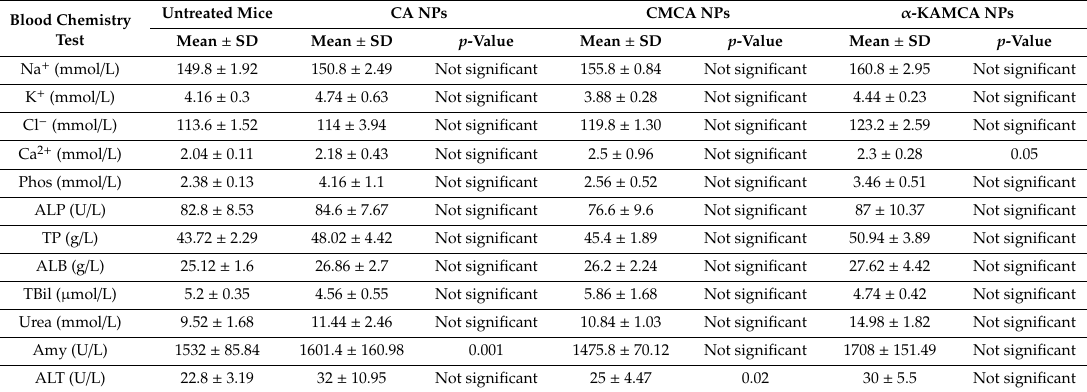
Table 5. Sub-chronic toxicity study in mice treated with CA, CMCA, and α -KAMCA NPs ( n = 5). Blood Chemistry